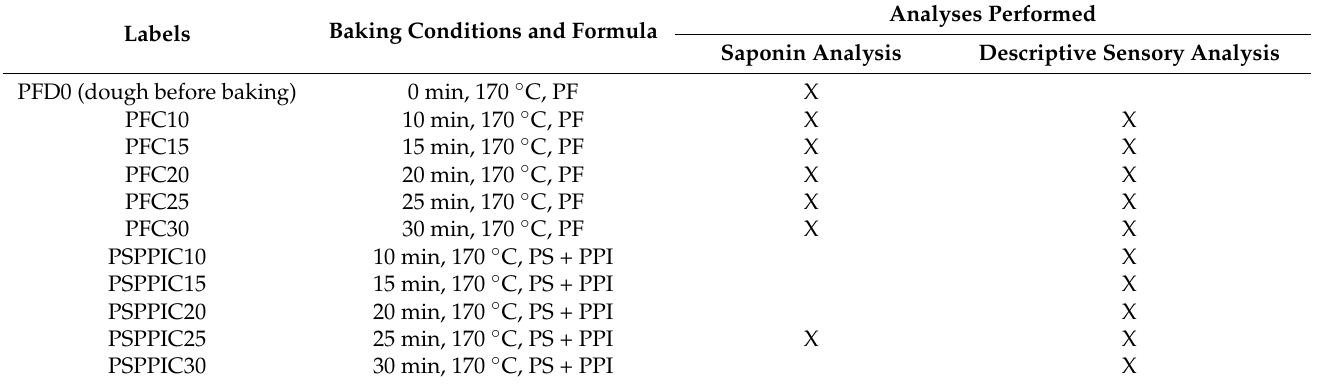
Table 1. Cakes, baking conditions, and types of analyses (X =